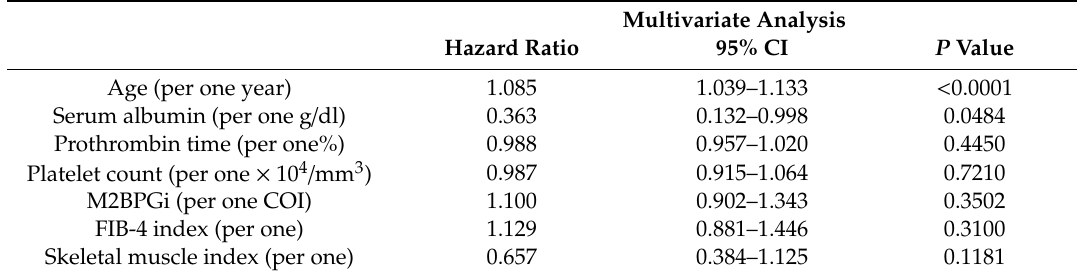
Table 5. Multivariate analyses of factors linked to the low grip strength for female